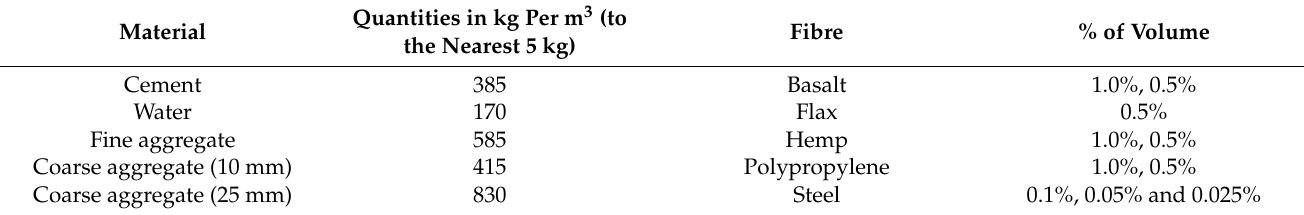
Table 4. Concrete mix designed for the preliminary